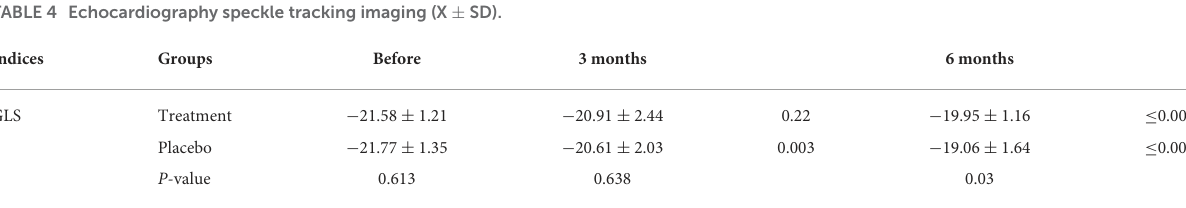
TABLE 4 Echocardiography speckle tracking imaging (X ± SD).